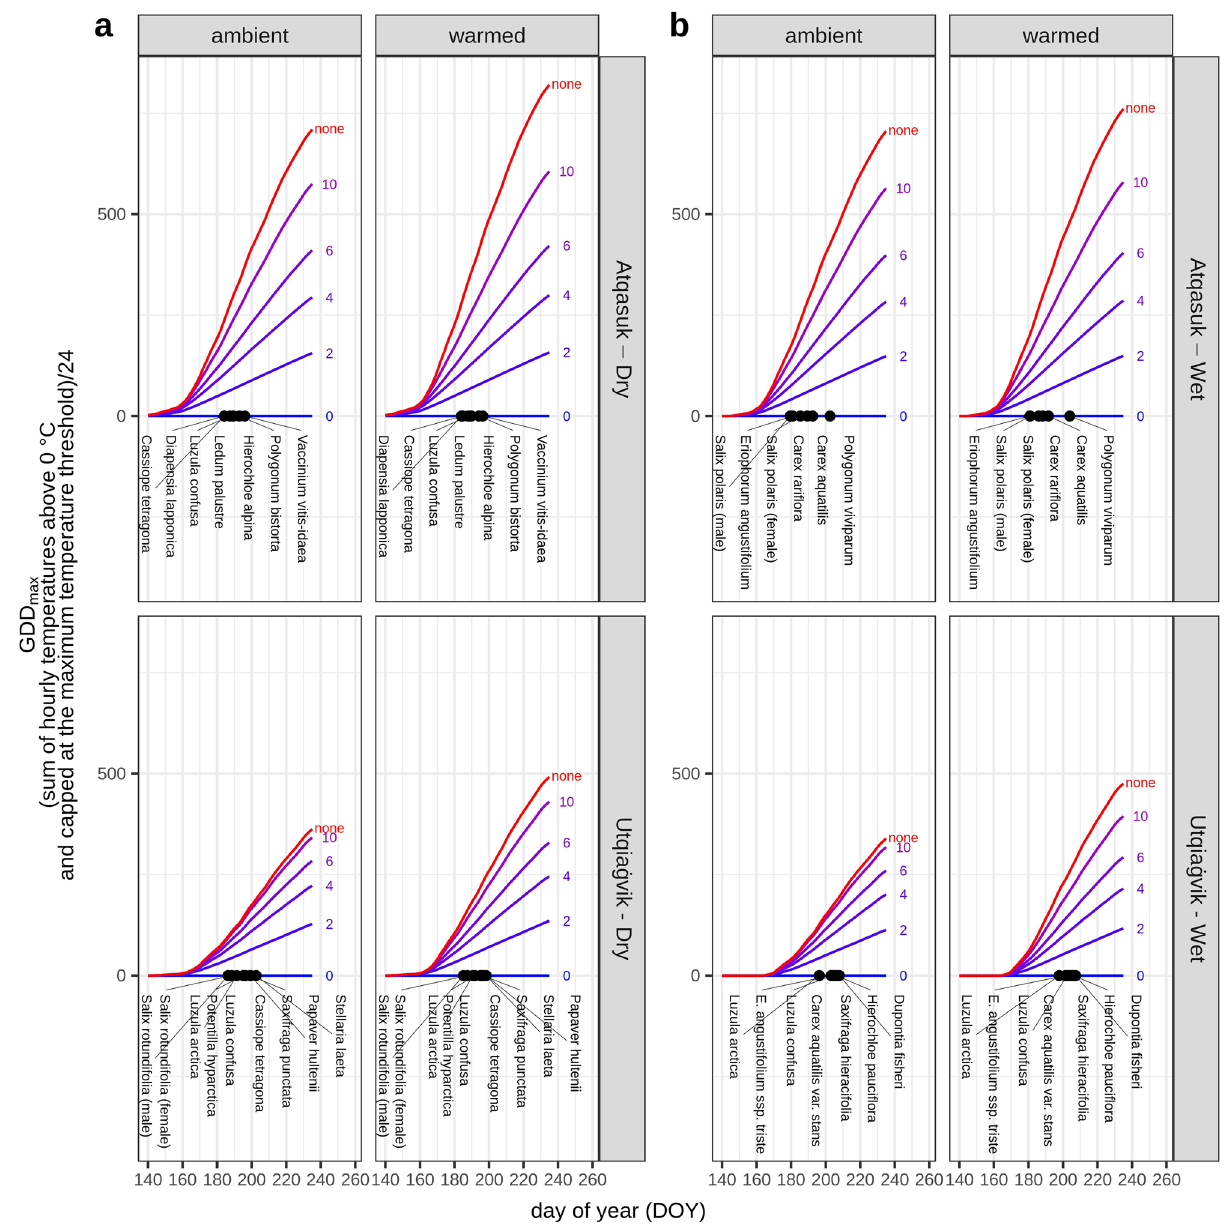
Figure 1. Growing degree day (GDD) sums calculated using different maximum temperature thresholds. Lines represent GDD max on a given day (averaged across years) for each location in both ambient and warmed plots, calculated with a maximum threshold of 0, 2, 4, 6, 10 °C or no threshold. The spread between lines is smaller at higher than lower thresholds because of the relatively low frequency of higher temperatures. For comparison with plant phenology, the rugplot shows the mean day of flowering averaged across years for plants monitored at each